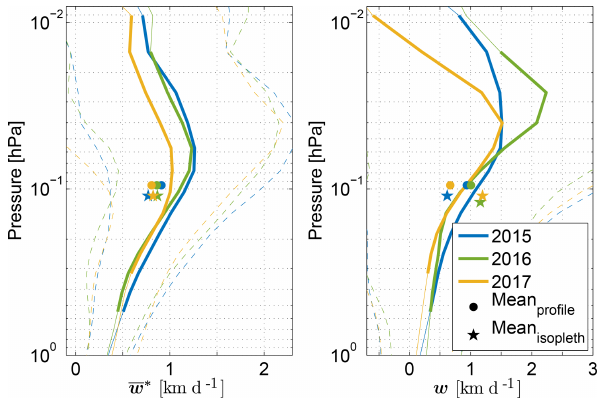
Figure 9. Vertical component of the residual mean meridional cir- culation w ∗ and zonal mean vertical wind w profiles averaged be- tween 15 September and 1 November for the years 2015, 2016 and 2017. The dashed line is the standard deviation and the bold line indicates the altitude range which was covered by the zonal mean 5.5ppm isopleth of SD-WACCM in the same time period. The points indicate the mean of the profiles over this altitude range and the stars indicate the mean along the zonal mean 5.5ppm isopleth of